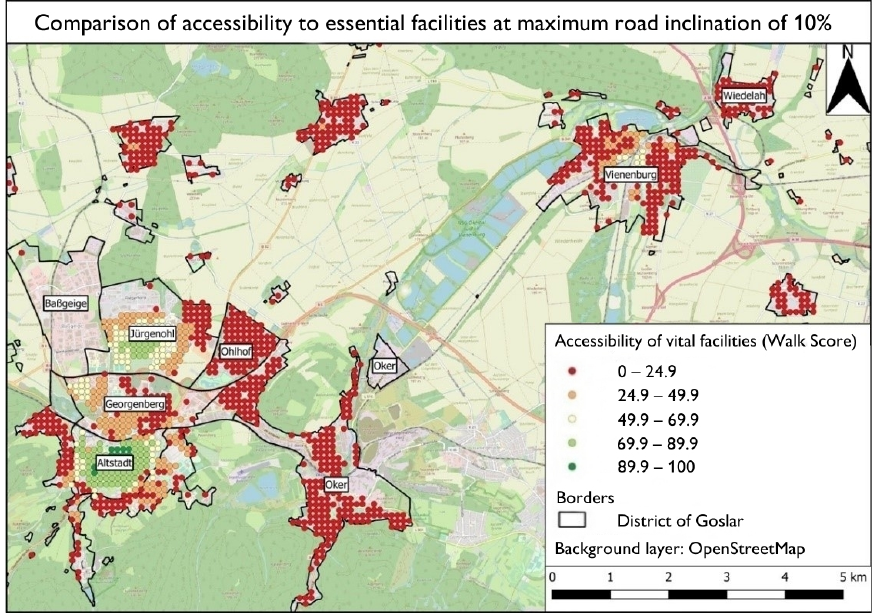
Figure 5. Walk Score map for essential supply facilities in Goslar. Background map OpenStreetMap contributors.